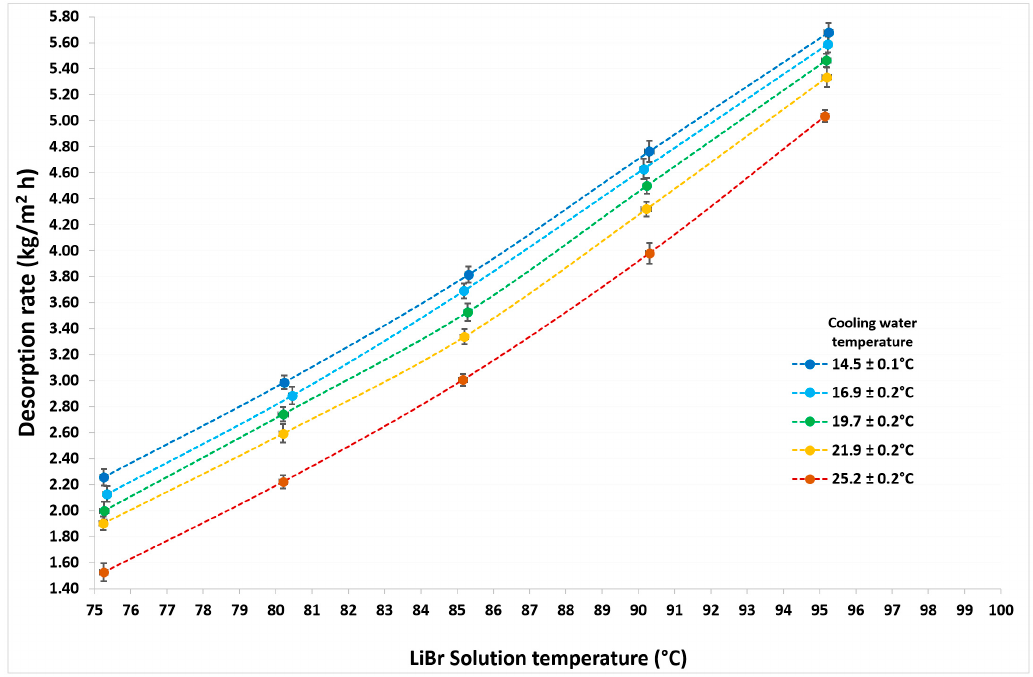
Figure 4. Desorption rate as a function of LiBr solution and cooling water temperatures.